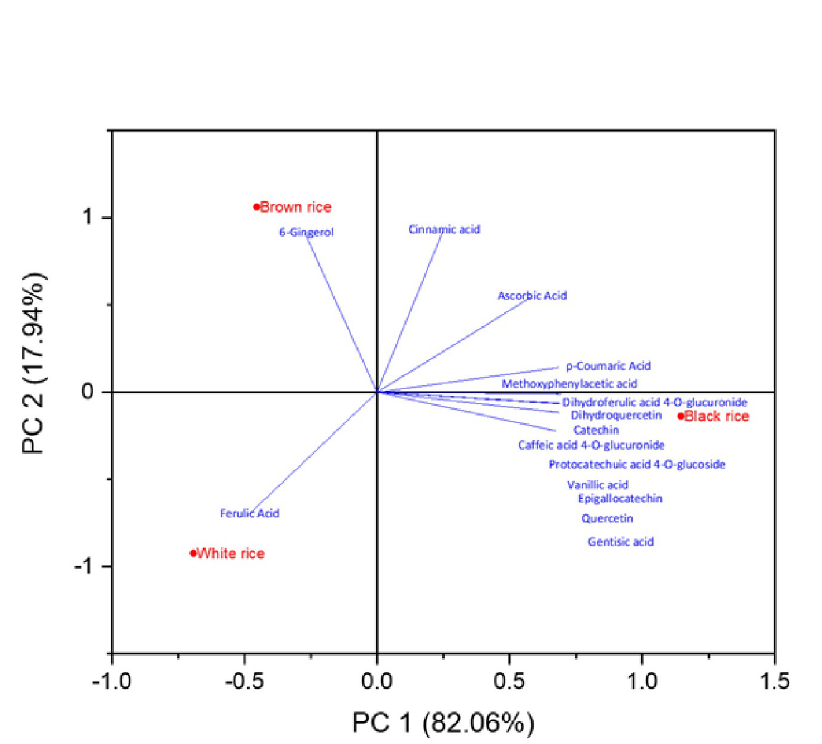
Fig 4. Principal component analysis (PCA) of rice samples (white, brown & black) was shown by comparing PC 1 (component 1) with PC2 (component 2).